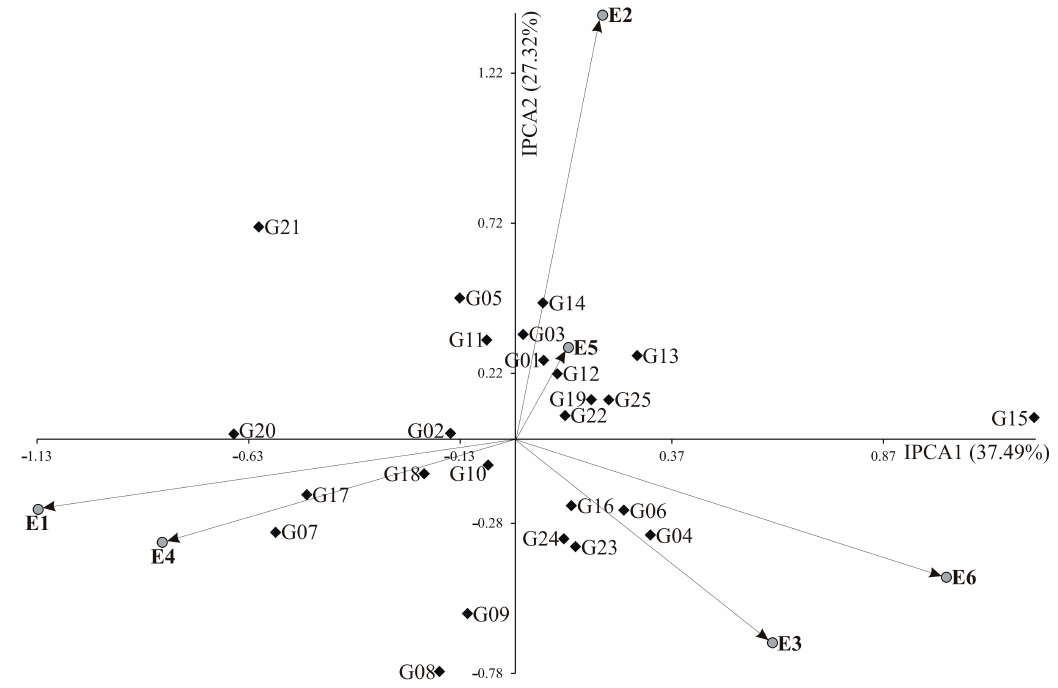
Figure 5. Biplot for genotype by environment interaction of C18:3 content in 25 winter oilseed rape ( B. napus ) genotypes in six environments, showing the effects of primary and secondary components (IPCA 1 and IPCA 2, respectively) (E1—Borowo, 2015; E2—Borowo, 2016; E3—Borowo, 2017; E4— Ł agiewniki, 2015; E5— Ł agiewniki, 2016; E6— Ł agiewniki, 2017).